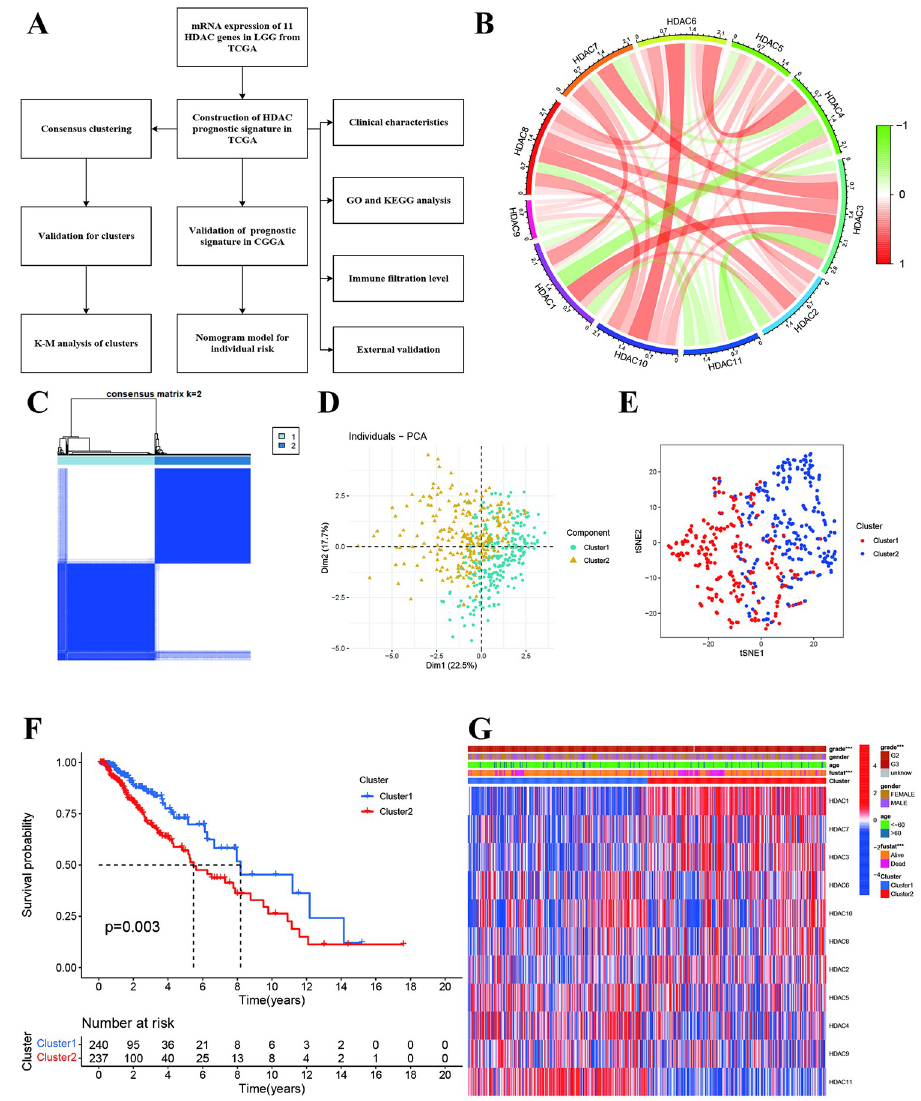
Fig 1. Molecular subtypes for low-grade glioma based on HDAC genes. A: The flow chart of overall data processing. B: Circle plot showed the correlations among HDAC genes. C: Consensus matrix identified two clusters. D: Principal component analysis showed two components. E: tSEN further confirmed two molecular clusters. F: Kaplan-Meier survival curves of two molecular clusters. G: Correlations of molecular clusters with clinical characteristics and HDAC